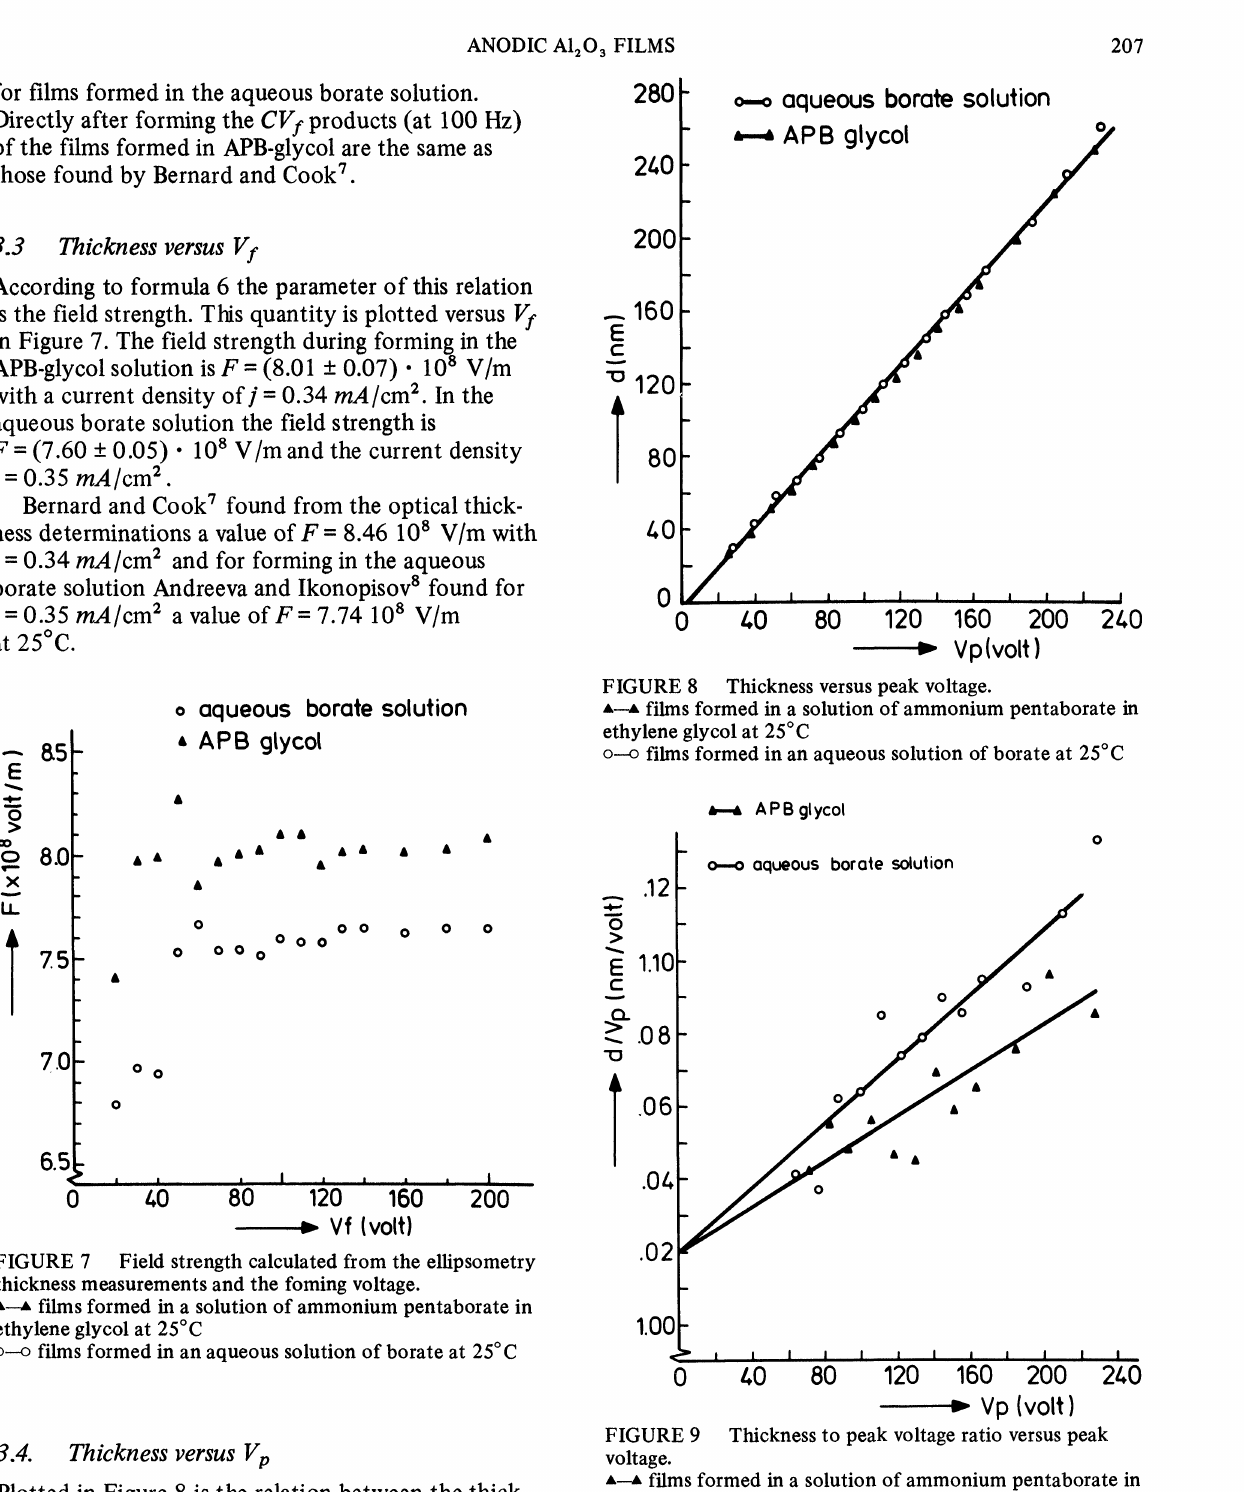
--- films formed in a solution of ammonium pentaborate in ethylene glycol at 25C o--- films formed in an aqueous solution of borate at